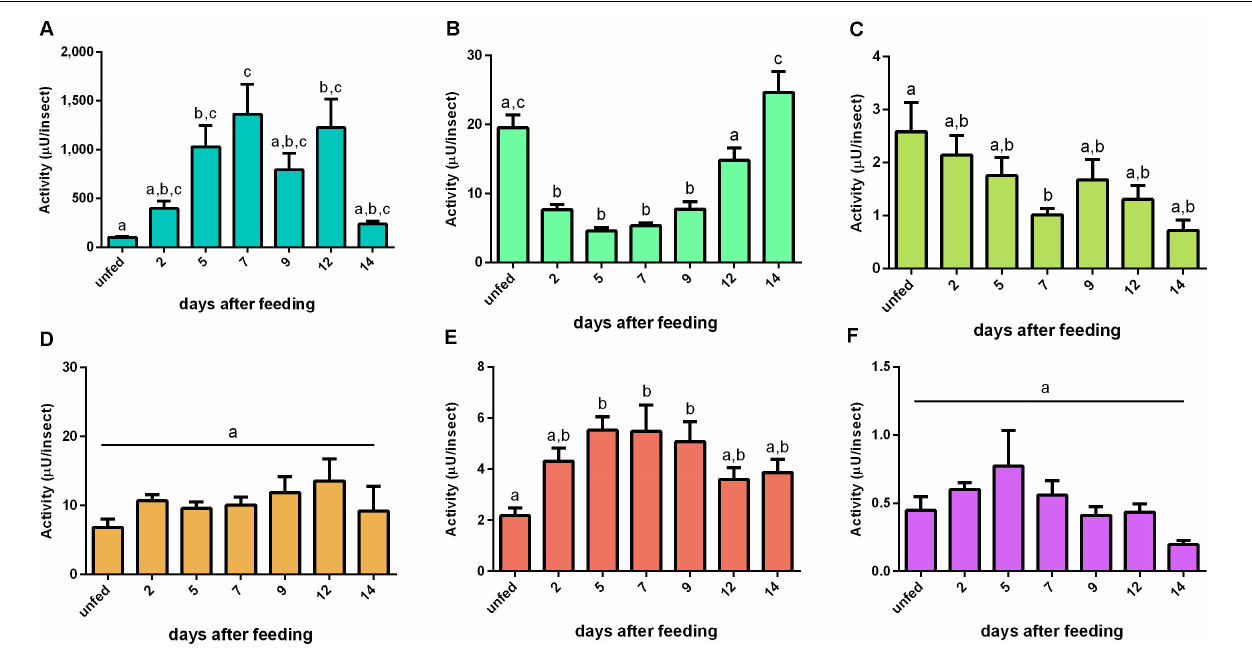
FIGURE 6 | Aminopeptidase activities ( µ U per insect) in the different digestive compartment tissues and luminal contents of Rhodnius prolixus male adults, unfed and at 2, 5, 7, 9, 12, and 14 daf on defibrinated rabbit blood, assayed in 0.2 M glycine-NaOH buffer, pH 9. (A) Anterior midgut tissues. (B) Posterior midgut tissues. (C) Hindgut tissues. (D) Anterior midgut contents. (E) Posterior midgut contents. (F) Hindgut contents. Figures are means ± SEM from nine different homogenate samples obtained from pools of two insects each. In a dataset, groups with the same superscript letter are not significantly different ( p > 0.05). Statistical analysis consisted of ordinary one-way ANOVA with Tukey’s multiple-comparisons test. Consider different scalings of activities.